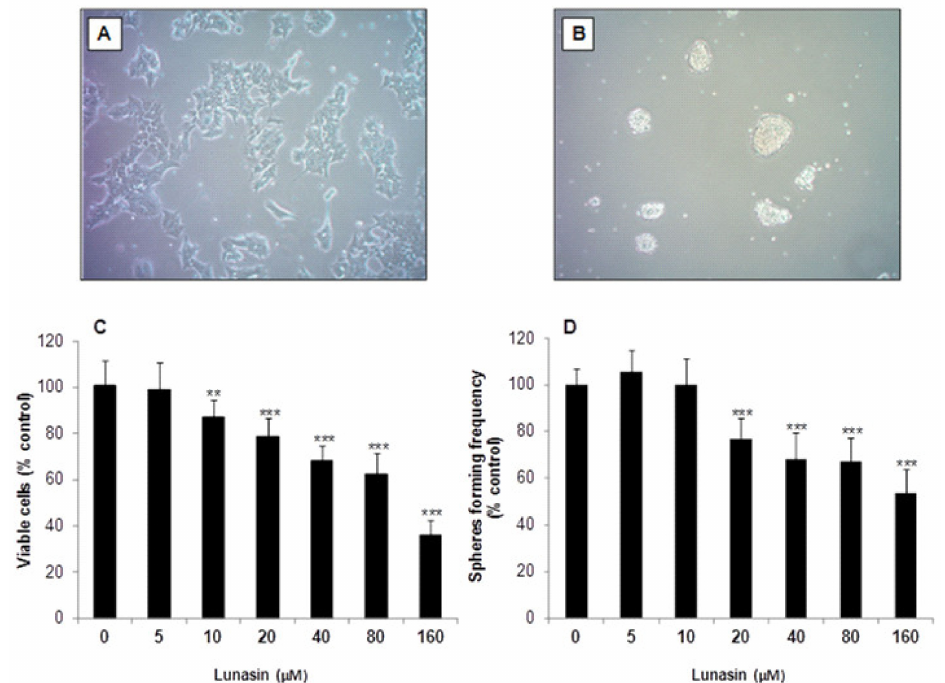
Figure 1. Cell culture and cytotoxic e ff ect of lunasin on colorectal cancer (CRC) cells. Representative images of ( A ) HCT-116 cells in adherent conditions and ( B ) enrichment culture of tumor-derived colon-spheres formed from the parental HCT-116 cell line under anchorage-independent conditions. ( C ) HCT-116 cells were treated with lunasin (5–160 µ M) for 72 h, and cell viability was determined by the MTT assay. ( D ) Colon tumorspheres were treated with lunasin (5–160 µ M) for 10 days, stained with crystal violet solution and counted. Results, expressed as percentage of control cells, are means ± standard deviation (SD) of the replicates of experiments carried out. ** ( p < 0.01), *** ( p < 0.001) significantly di ff erent from